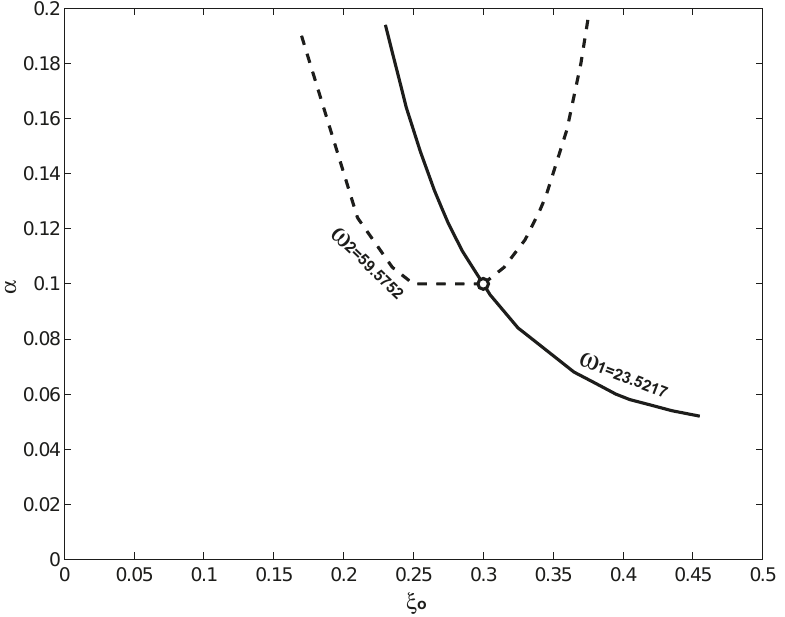
Figure 6. The projections of the two intersection curves obtained in Figures 4 and 5 into ξ plane. The intersection of the two curves is marked with a circle, which the α − o ξ ) = (0.1, 0.3) corresponds to ( α , o